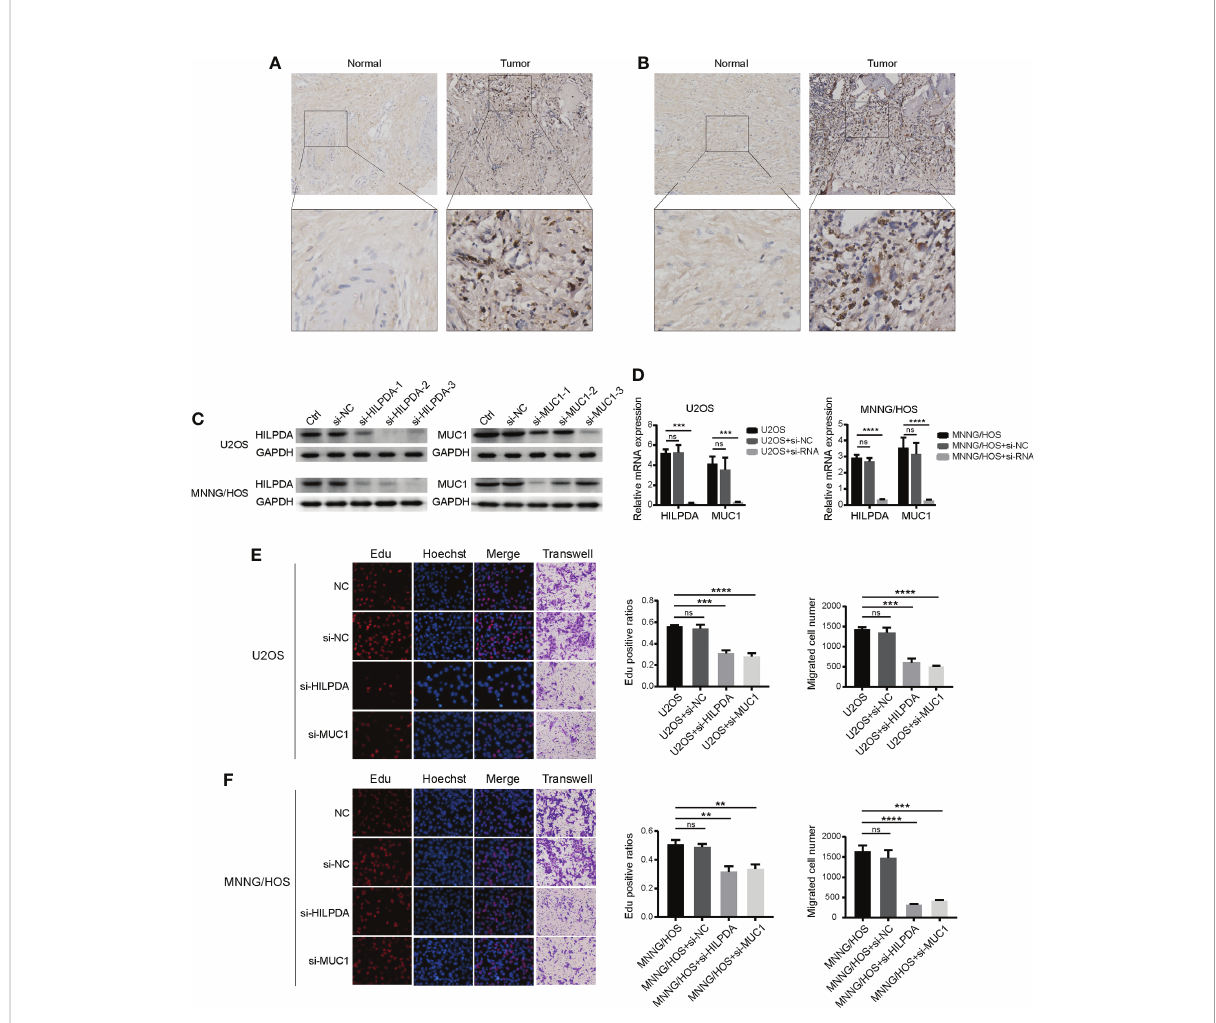
FIGURE 6 Expression of HILPDA or MUC1 in fl uenced the proliferation of OS cells. Representative immunohistochemical images of expressions of HILPDA (A) and MUC1 (B) in OS and para-carcinoma tissues. (C) Relative protein levels of HILPDA and MUC1 after si-RNA transfection (n=3) in U2OS and MNNG/HOS. (D) Relative mRNA expression levels of HILPDA and MUC1 using the optimal si-RNA (E, F) Representative images of EdU (red), Hoechst staining (blue) and transwell (purple) in U2OS and MNNG/HOS cells after si-RNA transfection.The ratios of EdU-positive (red) cells and migration cell numbers were calculated (n=3) after si-RNA transfection. Student t test ** P < 0.01; *** P < 0.001; **** P < 0.0001; ns, no signi fi